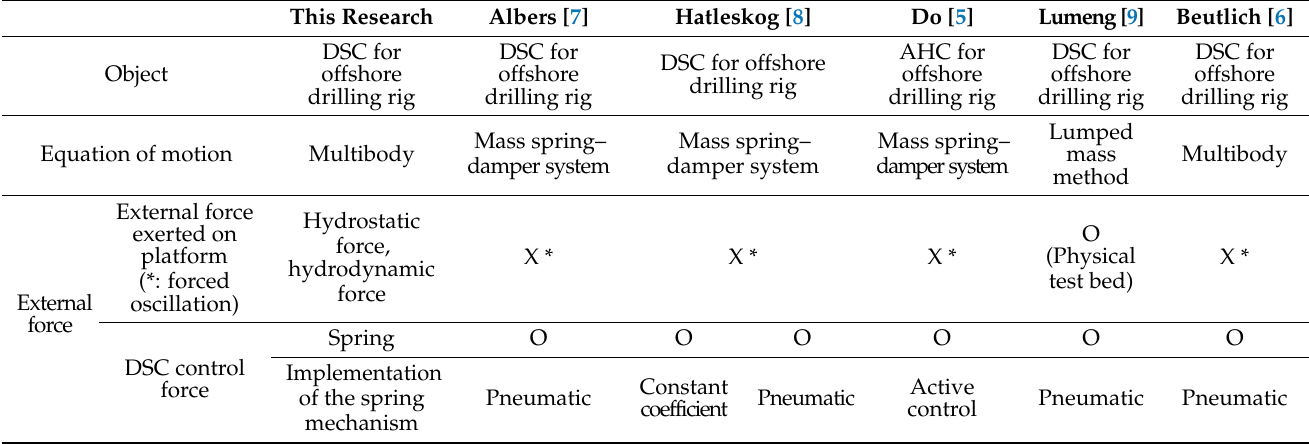
Table 2. Comparison of the features of this study with those of other